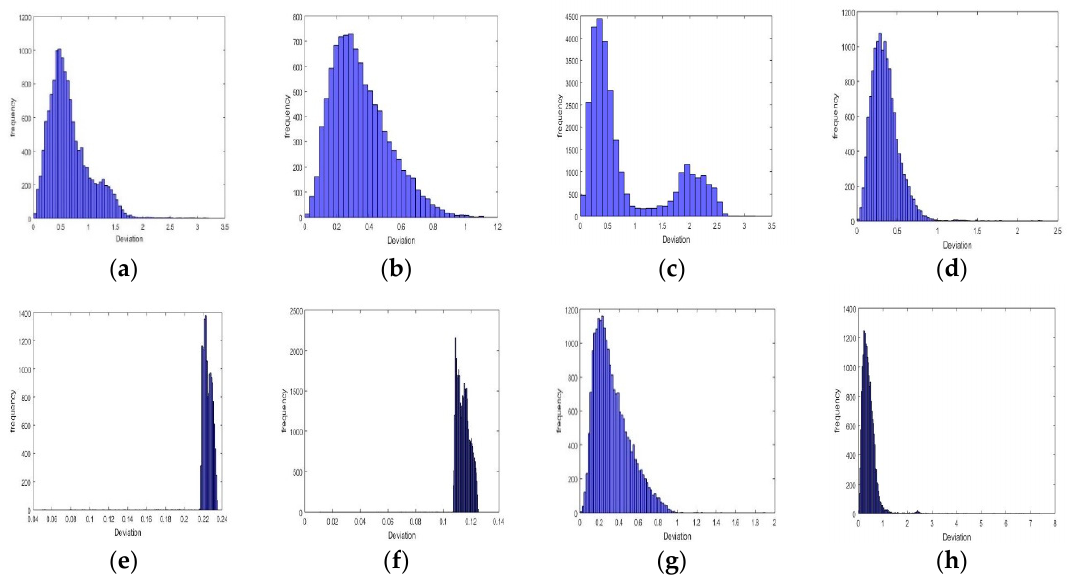
Figure 19. The histogram of inspection results in Figure 3. ( a )–( h ) are a series of inspection results histogram of vehicle body parts in Figure 3, respectively. Table 4. Inspection results (mm).